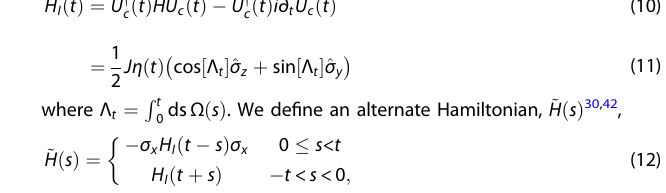
Fig. 4 Comparison of the performance of different control schemes for detection in a Lorentzian background spectrum using a full dynamical simulation of the qubit sensor for N s > 1 shots. Signal is chosen centered at ω 0 = J ¼ 10 correlation time J σ t = 1.17. a The different protocols shown here are chosen for the detection time t s ¼ t opt ; N rate for N s = 100. b Average error rates for classi fi cation of the presence or absence of the signal given by the average probability of false positive and false negative outcomes, as a function of the number of shots of the protocol (see Fig. 1). For a given number of shots, the threshold for the detector is chosen to minimize the total probability of FP and FN